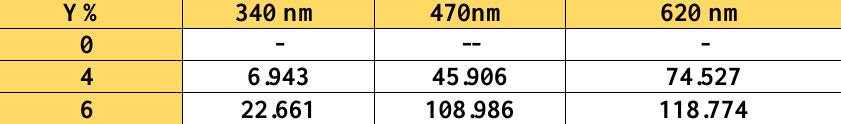
O with yttrium Photo 3 4 O 3 4